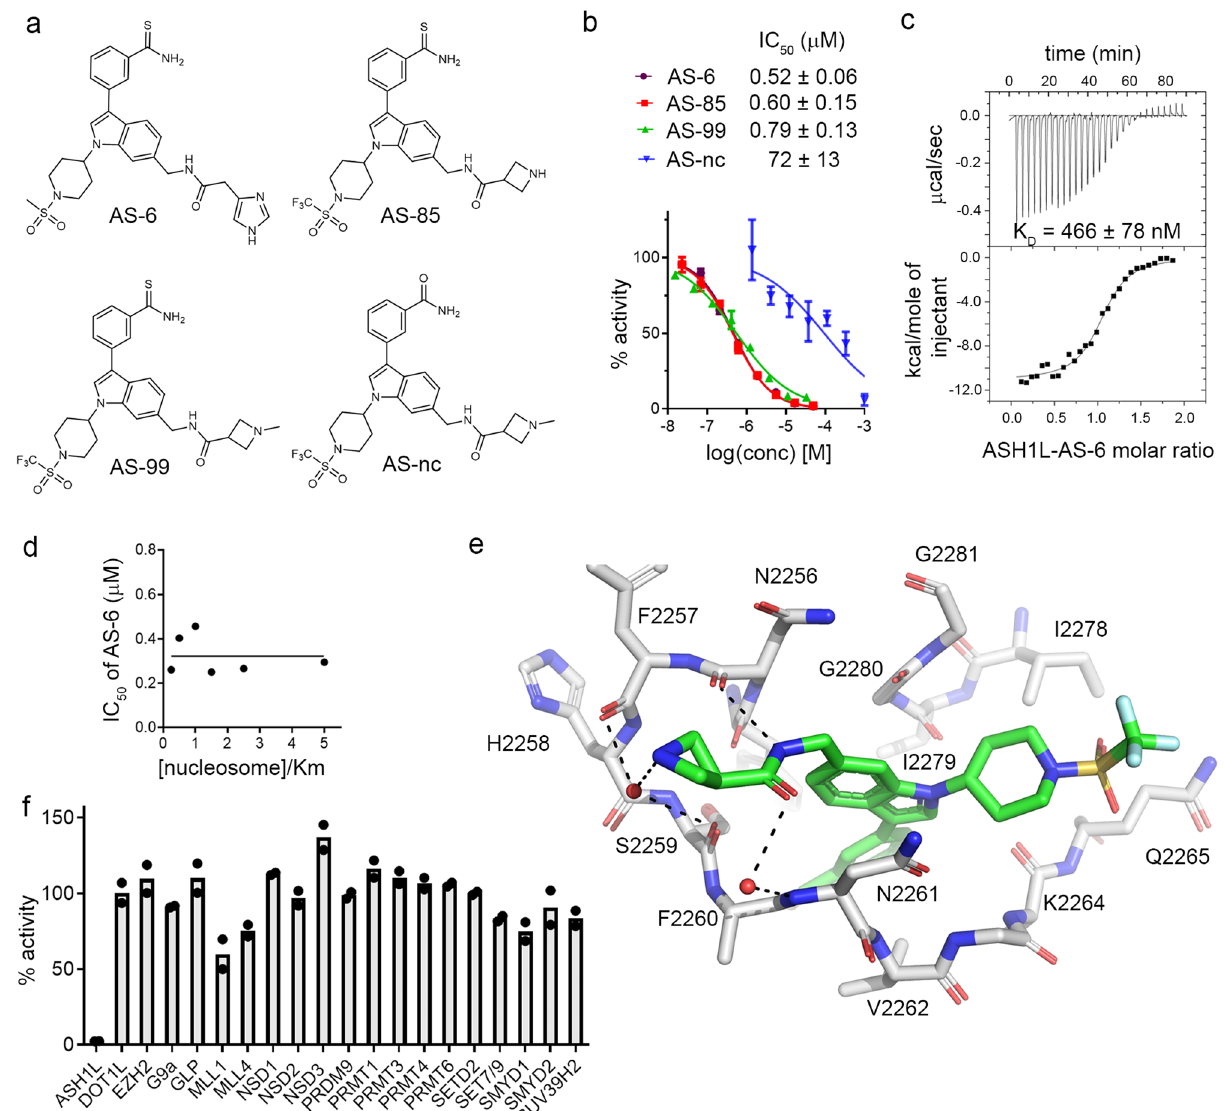
Fig. 4 Structure-based optimization of ASH1L inhibitors. a Chemical structures of ASH1L inhibitors developed using structure-based design. b Titration curves and IC 50 values from the HMT assay. Data are mean ± s.d. from two independent experiments. c Binding isotherm from the ITC experiment performed for the binding of AS-6 to ASH1L. Data are mean ± s.d. from two independent experiments. A representative binding isotherm is shown. d Mechanistic studies from HMT assay with the IC 50 values for AS-6 measured at various nucleosome concentration demonstrating non-competitive inhibition with nucleosome. e Crystal structure of ASH1L- AS-85 complex determined at 1.69 Å resolution. Selected ASH1L residues (gray carbons) and AS- 85 (green carbons) are shown in sticks. Hydrogen bonds are shown as dashed lines. f Selectivity of AS-99 tested at 50 µ M concentration against a panel of histone methyltransferases. Data represent two independent experiments each performed in